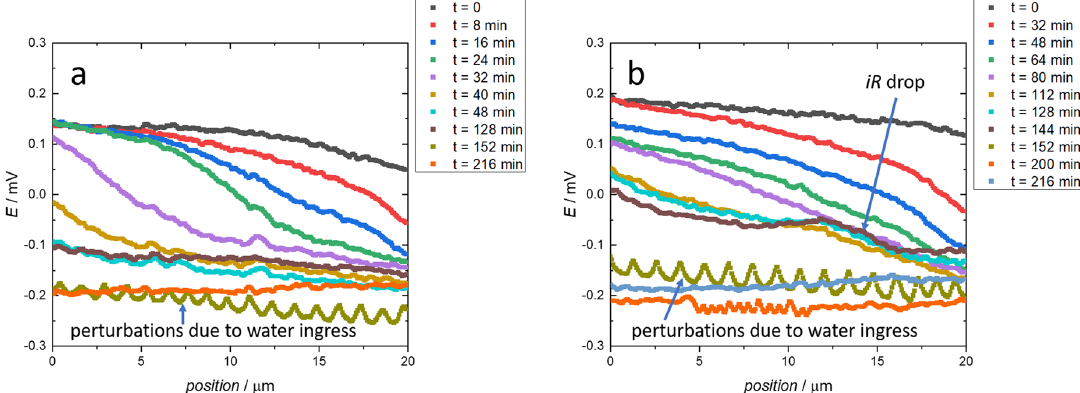
Fig. 10 Surface potential pro fi les extracted from the maps on the sample 10C-12O. Electrode potential ( E ) vs. horizontal axis position, extracted from the SKPFM images in Fig. 9 at a vertical axis position of a 18.75 μ m (defective Cr – O) and b 6.51 μ